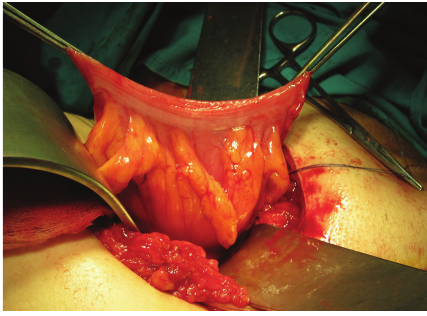
Figure 8: Harvested segment of sigmoid colon with its mesentery.